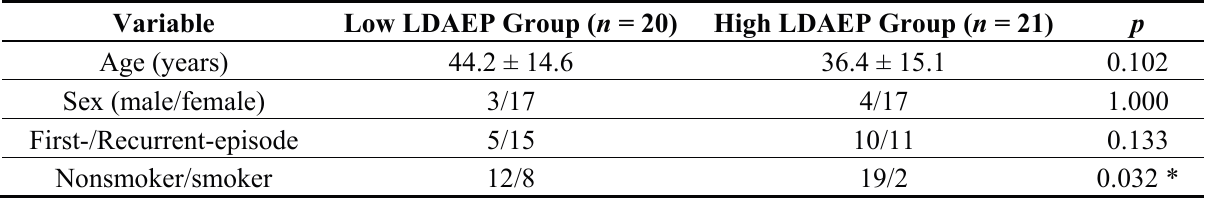
Table 3. Comparison of demographic data, clinical variables, and the LDAEP between MDD patients with low and high pretreatment LDAEP (dichotomized at the median into low vs.